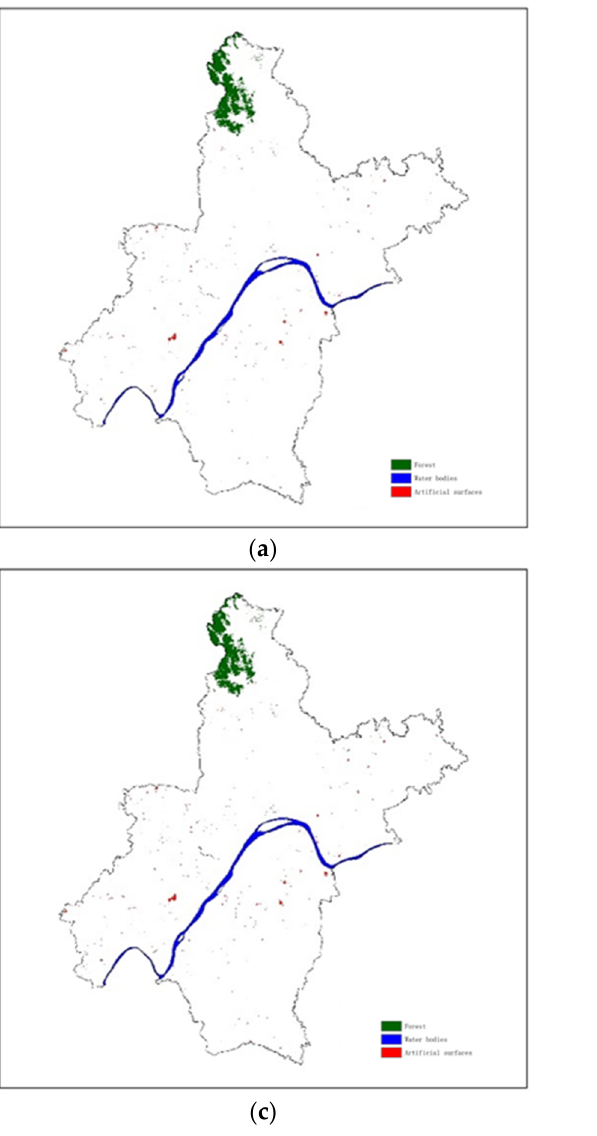
Figure 6. Extracted training data: ( a ) pixels correctly classified, ( b ) corrected pixels (shown in exaggeration in order to be legible), and ( c ) union of pixel segments for ( a , b ). Table 3. Area proportions estimated with different estimators